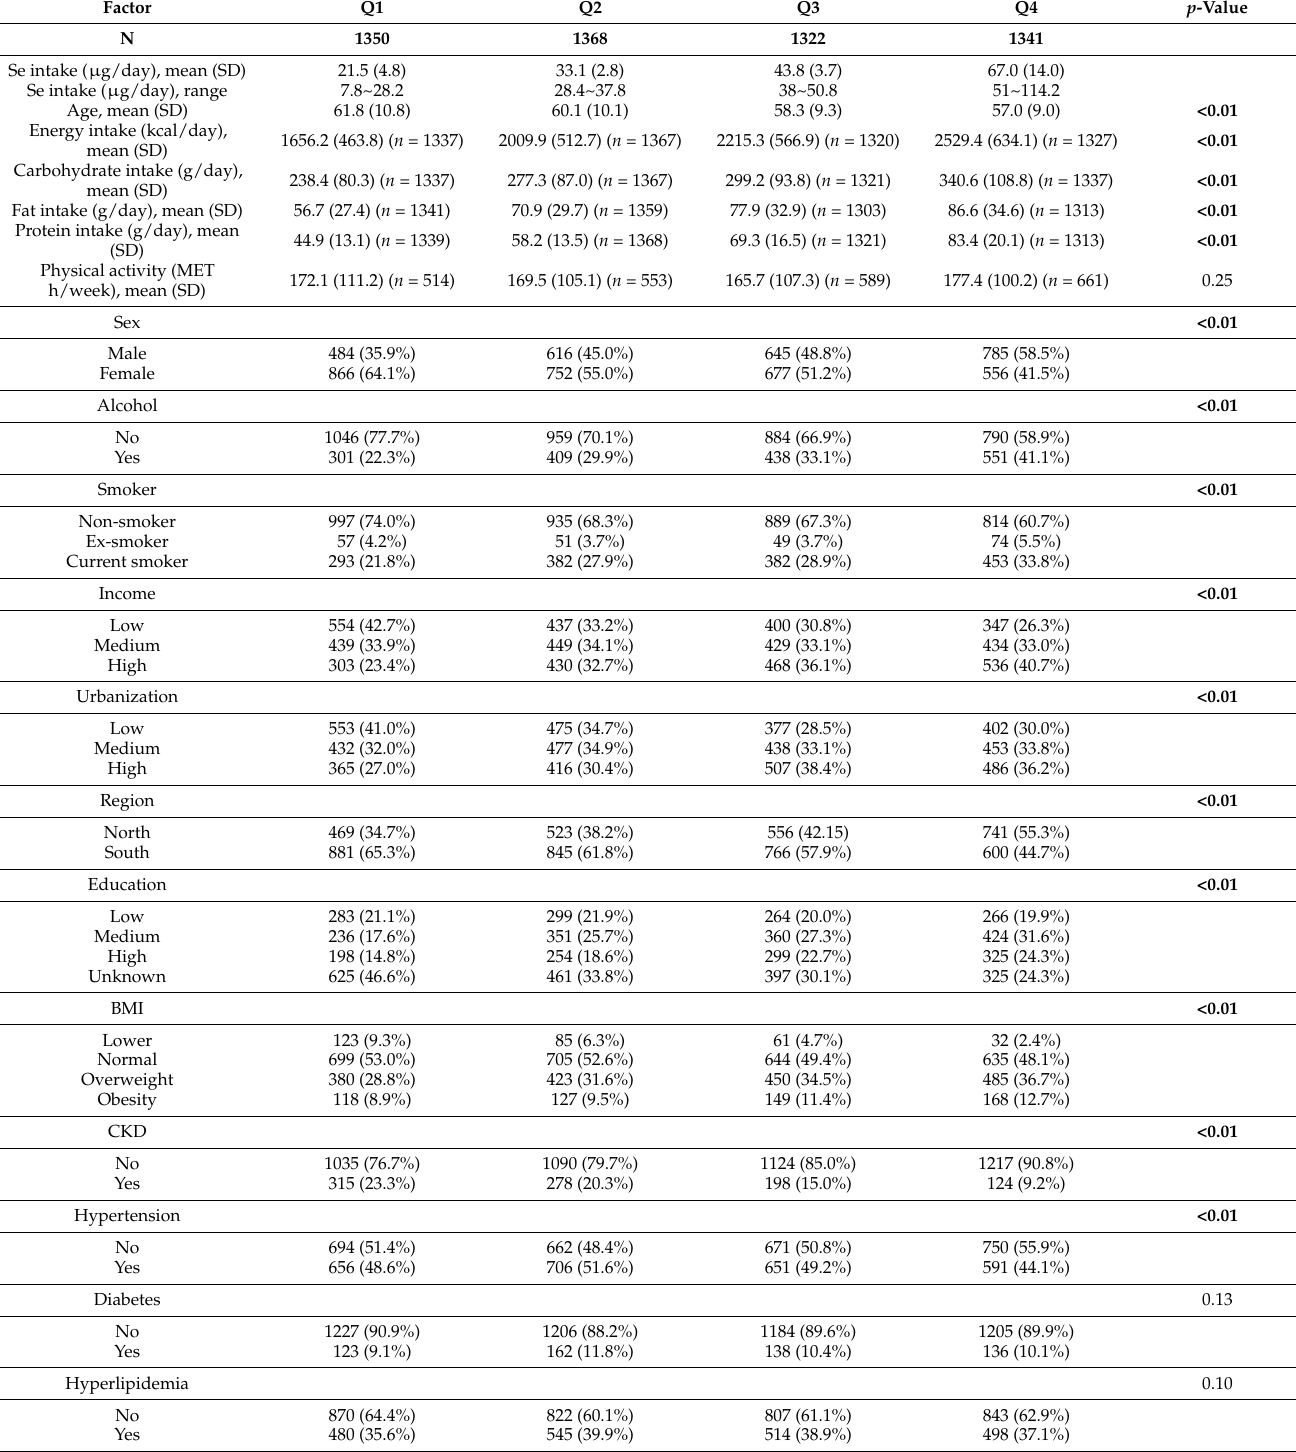
Table 1. Sample characteristics by quartiles of Se intake: CHNS ( n =